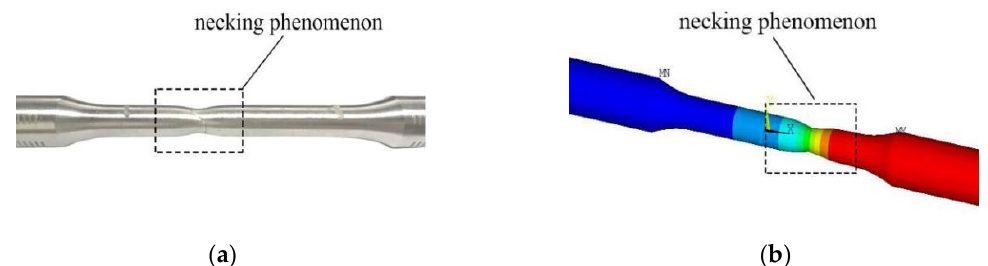
Figure 12. Failure morphology of specimen and simulation: ( a ) failure morphology of specimen; ( b ) failure morphology of finite element simulation.